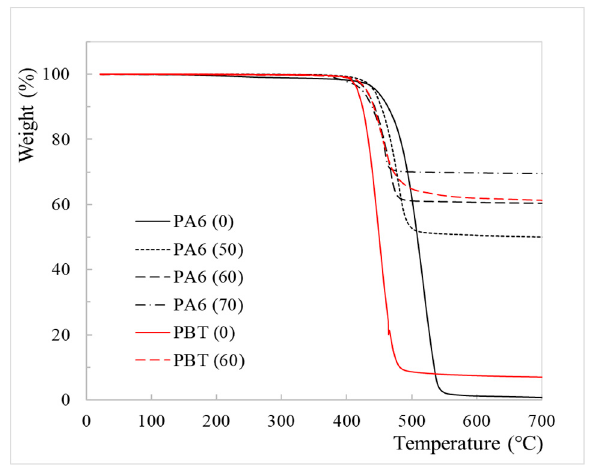
Figure 3. Thermal weight decomposition and derivative thermograms of the various composites .